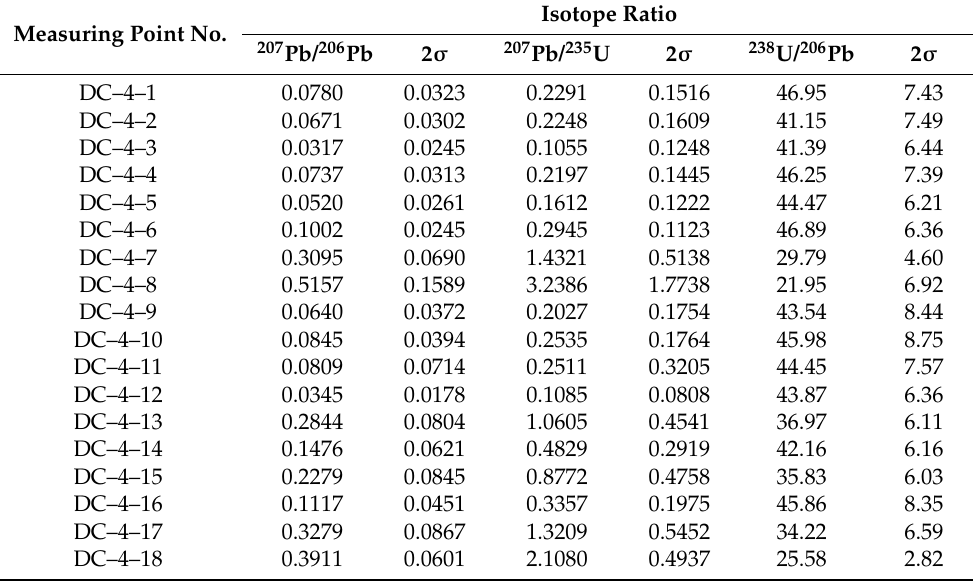
Table 1. LA–ICP–MS U–Pb isotope data of cassiterite from the Dongcao muscovite granite. Measuring Point